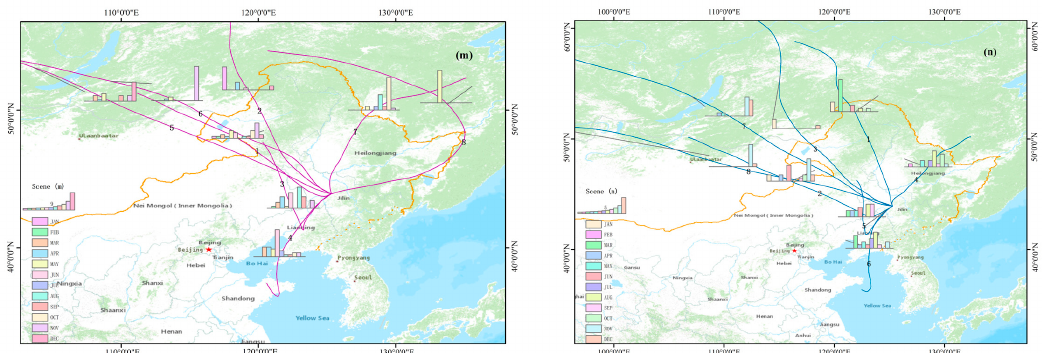
Figure 8. ( a – n ). Cluster analysis of the backward trajectories under specific scenes in Changchun in 2018: ( a ) working day; ( b ) spring; ( c ) summer; ( d ) autumn; ( e ) winter (heating period); ( f ) non-heating